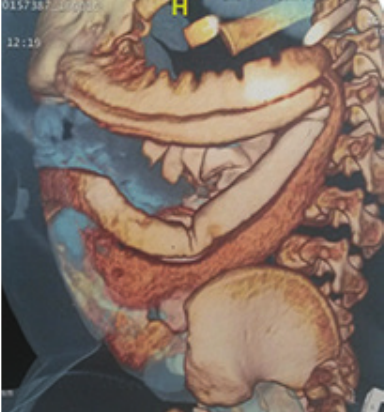
Figure 1: Computed tomography scan with double opacification showed a tubular recto-colonic duplication with proximal communication at left colic angle